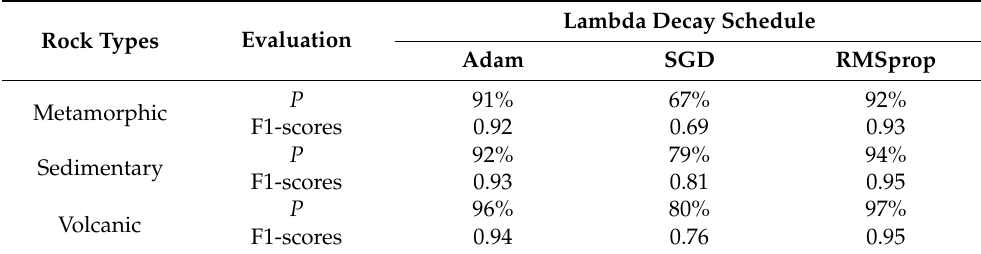
Figure 24. Confusion matrixes: ( a ) RMSprop optimizer; ( b ) SGD optimizer; ( c ) Adam optimizer. Table 9. Detailed classification results for all rock types. Table 9. Detailed classification results for all rock